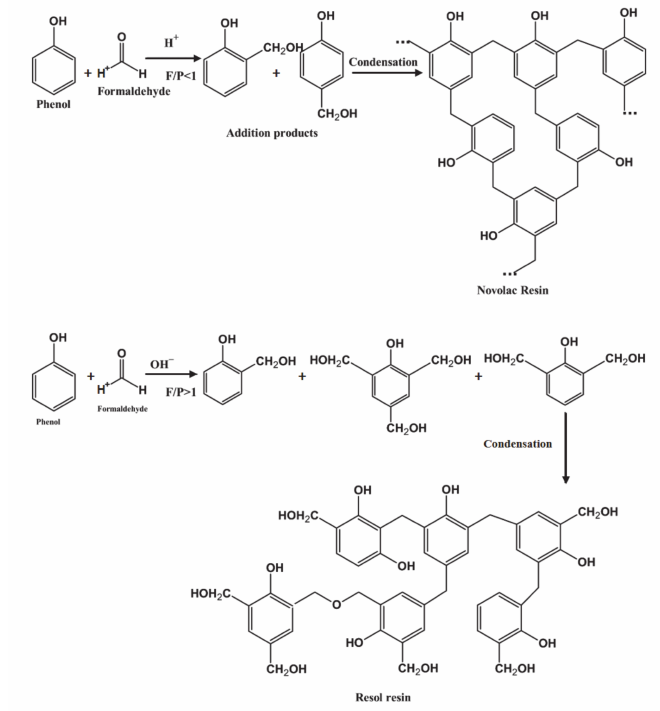
Figure 1. Schematic representation of resol and novolac resin